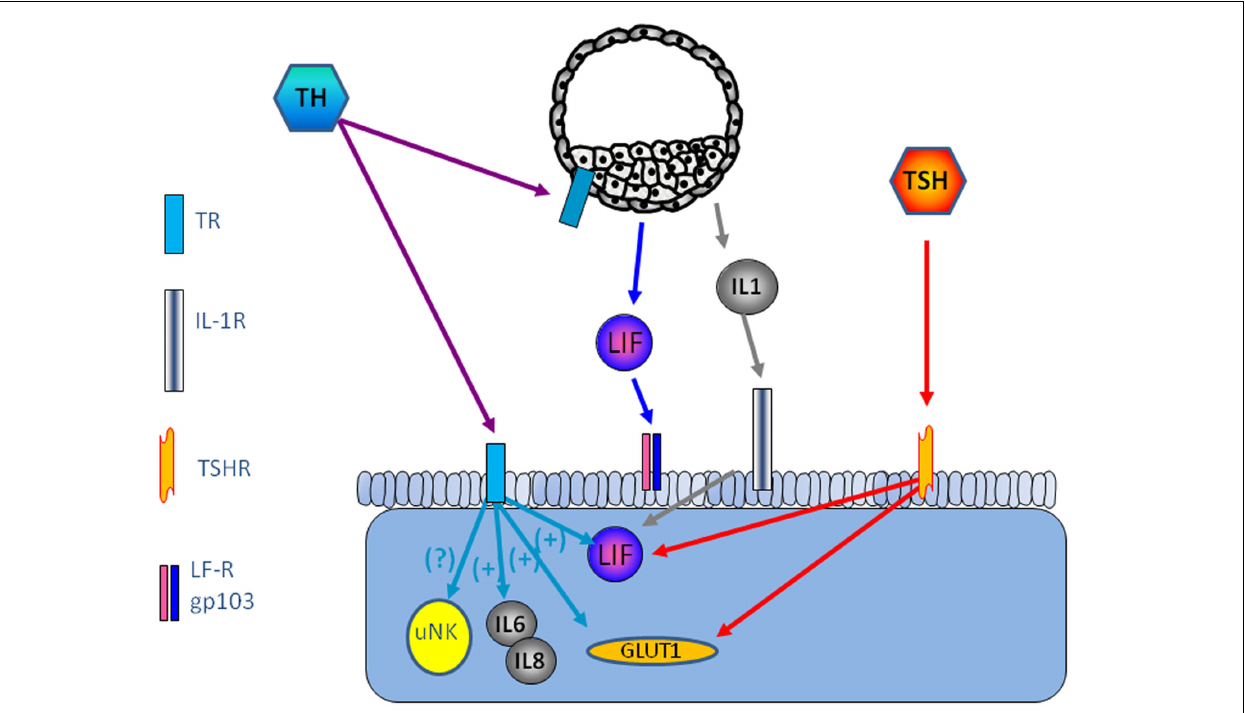
FIGURE 1 | Possible interaction between the embryo and endometrium is shown. The thyroid system is involved in the regulation of LIF and interleukins, key factors for successful implantation.